Question: What does this figure show? Answer in one sentence.
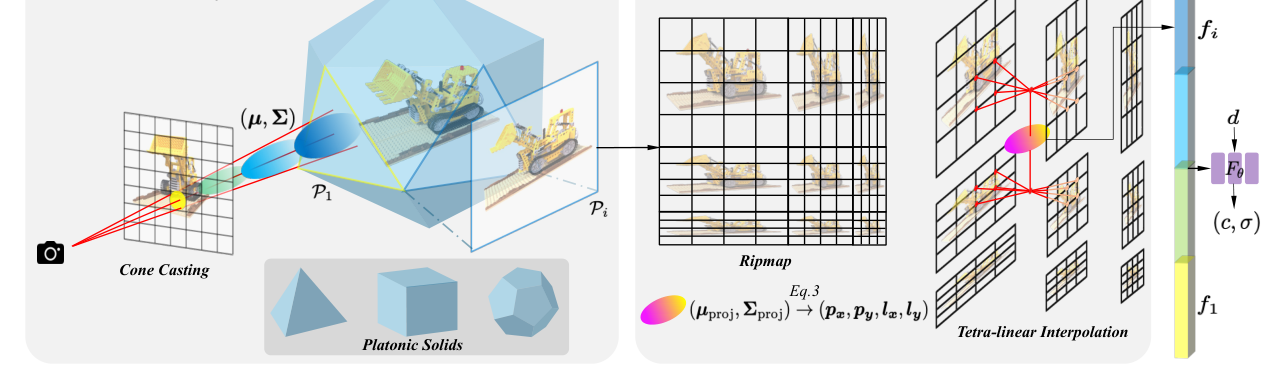
Answer: Overview of our Rip-NeRF. We first cast a cone for each pixel, and then divide the cone into multiple conical frustums, which are further characterized by anisotropic 3D Gaussians parameterized by their mean and covariance (𝝁, 𝚺). Next, to featurize a 3D Gaussian, we project it onto the unparalleled faces of the Platonic solid, denoted as {P𝑖| 𝑖= 1, ...,𝑛} to form a 2D Gaussian (𝝁proj, 𝚺proj), while the Platonic solid’s faces are represented by the Ripmap Encoding with learnable parameters. Subsequently, we perform tetra-linear interpolation on the Ripmap Encoding to query corresponding feature vectors 𝑓𝑖for the 2D Gaussian, where the position (𝑝𝑥, 𝑝𝑦) and level (𝑙𝑥, 𝑙𝑦) used in the interpolation are determined by the mean and covariance (𝝁proj, 𝚺proj) of the 2D Gaussian, respectively. Finally, feature vectors 𝑓𝑖from all Platonic solids’ faces and the encoded view direction 𝑑are aggregated together to estimate the color 𝑐and density 𝜎of the conical frustums by a tiny MLP 𝐹𝜃.